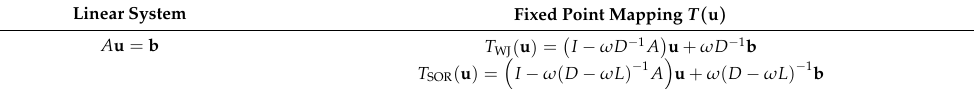
Table 1. The different ways of rearranging the linear systems (12) into the form u = T ( u ) . Linear System Fixed Point Mapping T ( u )